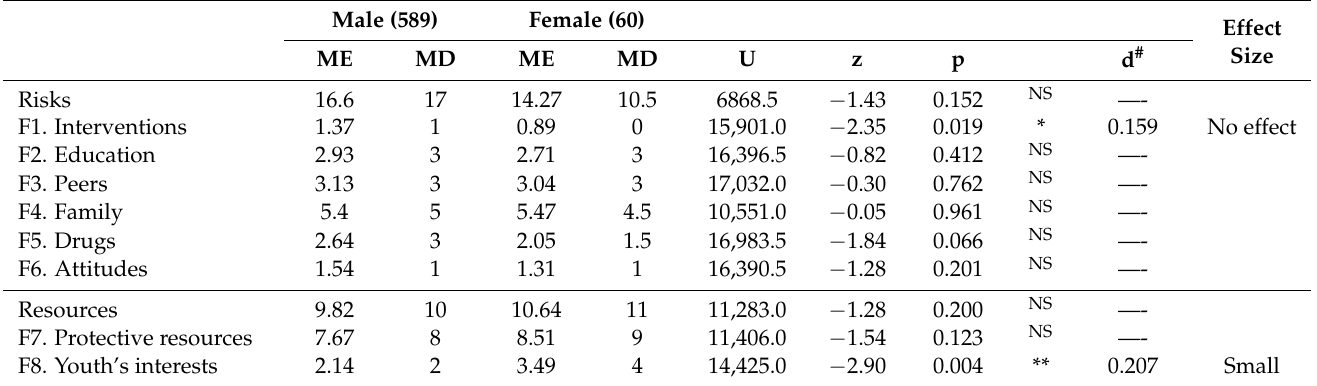
Table 6. Comparative characterization of risks and resources in the FER-R according to the sex of the